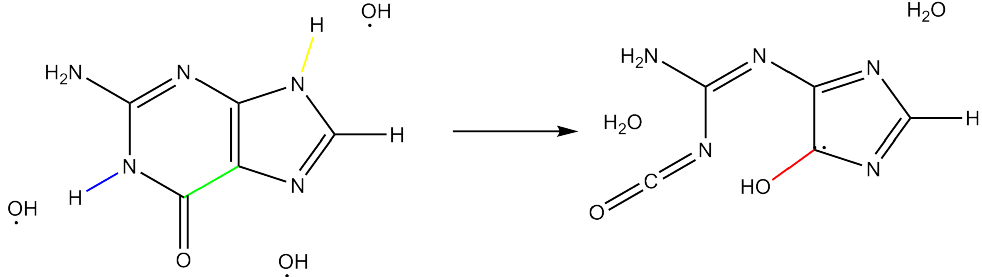
Figure 10. Reaction mechanism which leads to the formation of 3f